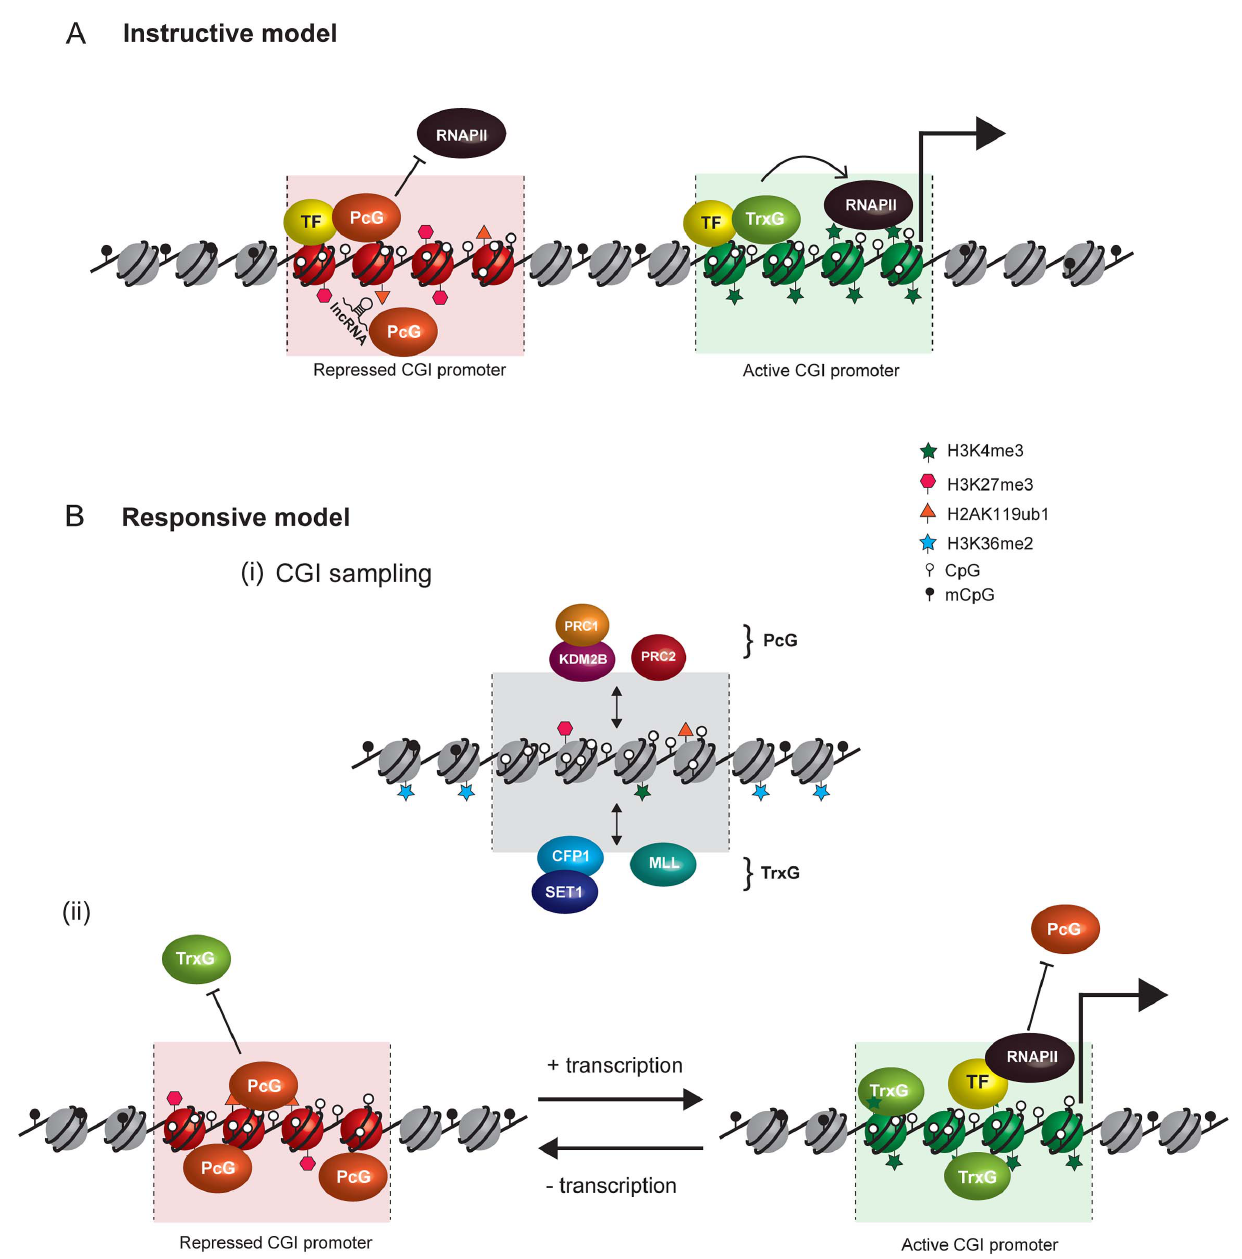
Figure 2. Comparison of instructive and responsive models for recruitment of PcG complexes to CpG islands at target gene promoters. DNA methylation and hypomethylation are indicated with filled and open lollipops, respectively. Repressed PcG–associated CpG islands are colored red and active TrxG–associated CpG islands green. (A) Classical instructive models invoke that sequence-specific DNA binding transcription factors (TF) and/or long noncoding RNAs (lncRNA) interact biochemically with PcG complexes and thereby target these complexes to defined promoters at which PcG-mediated histone modifications inhibit RNA polymerase II (RNAPII) activity. At active gene promoters (large arrow), TFs directly recruit TrxG proteins that in turn deposit histone modifications linked to gene activation. (B) In the responsive model, it is proposed that both PcG (PRC1-KDM2B and PRC2) and TrxG (CFP-SET1 and MLL) complexes stochastically sample unmethylated CpG island chromatin irrespective of the transcriptional state of a given gene (i). This occurs either via CxxC zinc finger protein binding to unmethylated CpG or, in the case of PRC2, via sensing the absence of otherwise pervasive histone modifications, like H3K36me2. The outcome of PcG and TrxG sampling would then be responsive to the transcriptional state of the associated gene (ii). In the absence of transcription, the PcG protein–occupied chromatin state would accumulate by default (aided by positive feedback loops) and antagonize TrxG activity. Conversely, at transcribed genes, TFs, RNAPolII, and transcription would favor accumulation of TrxG factors with their associated activities, in turn antagonizing the function of PcG complexes. Importantly, in the responsive model, the capacity of PcG proteins to sample CpG island chromatin would permit them to respond to the transcriptional state of potential target genes without a requirement for direct interactions with TFs or